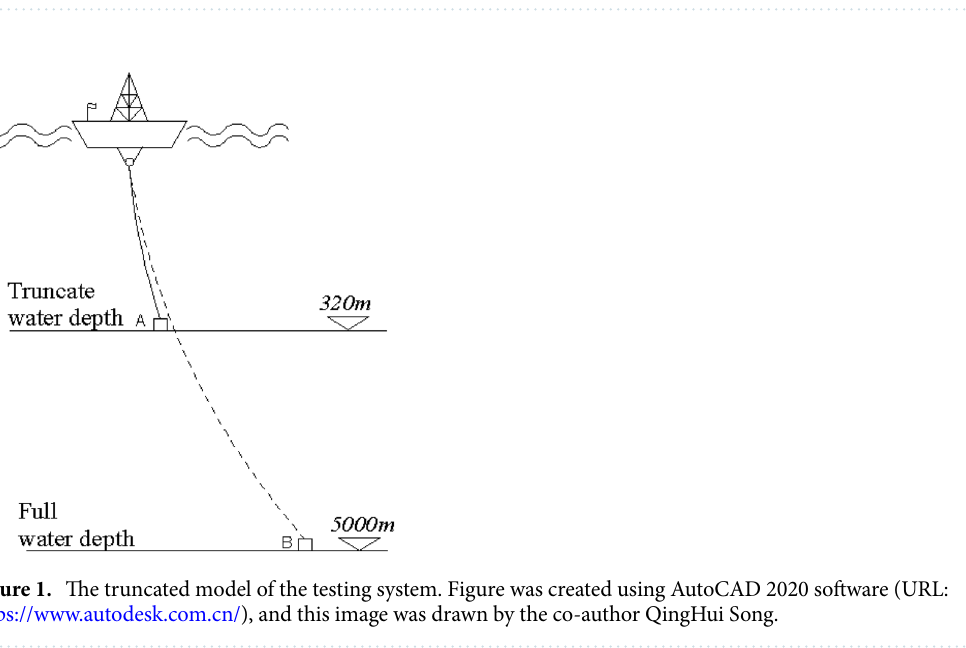
Table 2. Main parameters of prototype and model of mining vessel.